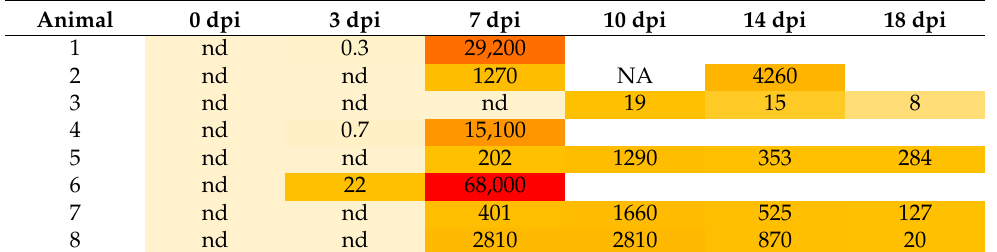
Table 3. Trial A: real-time PCR results of blood from 0 to 18 dpi. Genome detection in blood is presented as genome copies per reaction (5 µ L). nd: not detected; NA: due to technical and organizational problems samples could not be taken and analyzed. The color intensity indicates the relative level of viral loads (darker colors indicating higher loads, from light yellow to deep red).